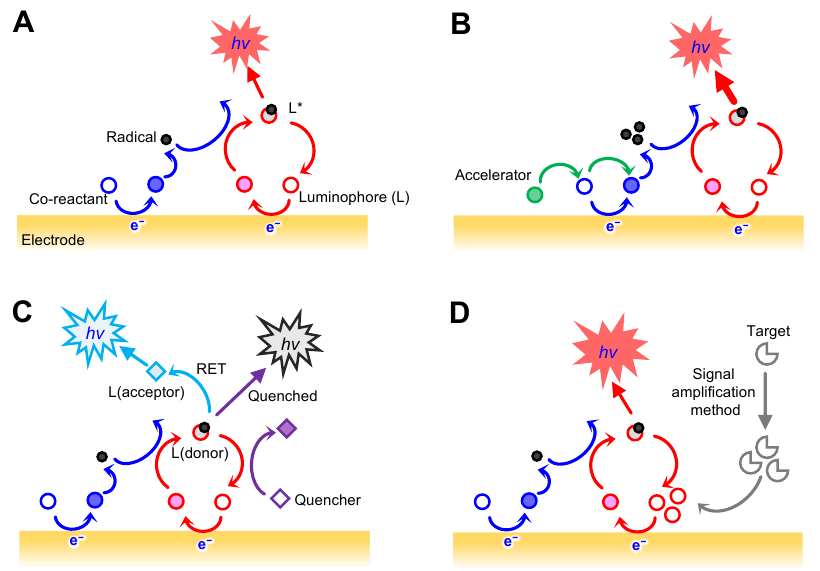
Figure 1. Schematic illustration of EC-sensing systems classified according to the reactions that drive the ECL signal emission. ( A ) Luminophore and co-reactant-involved reaction-based system; ( B ) co-reaction accelerator-involved reaction-mediated system; ( C ) Resonance energy transfer (RET) reactions-incorporated system; and a ( D ) signal amplification method-incorporated